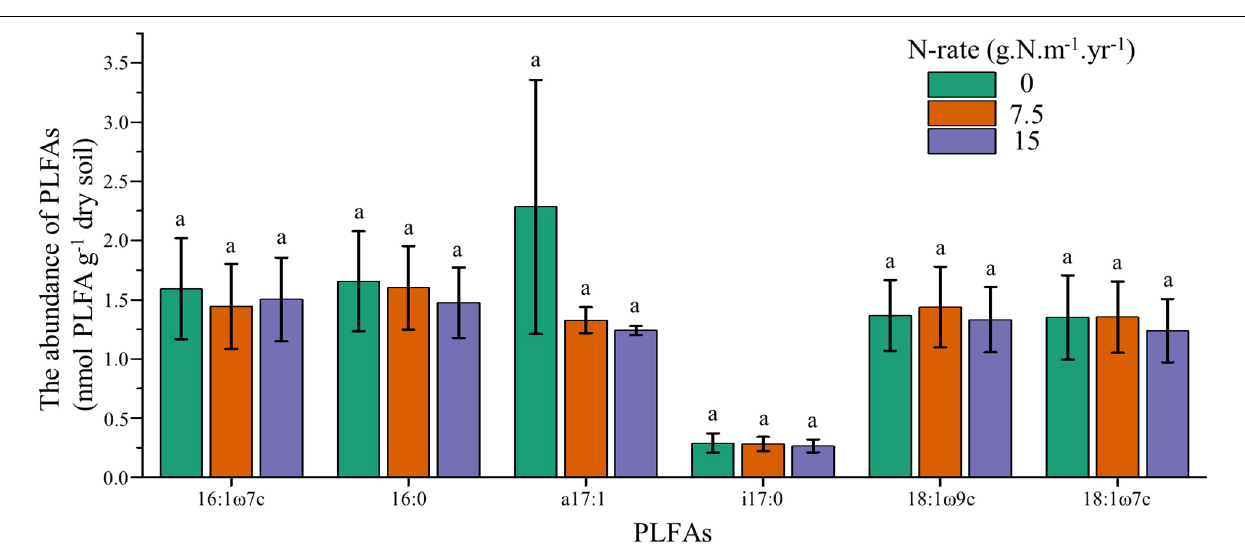
on the variation in soil microbial composition ( Figure 4A